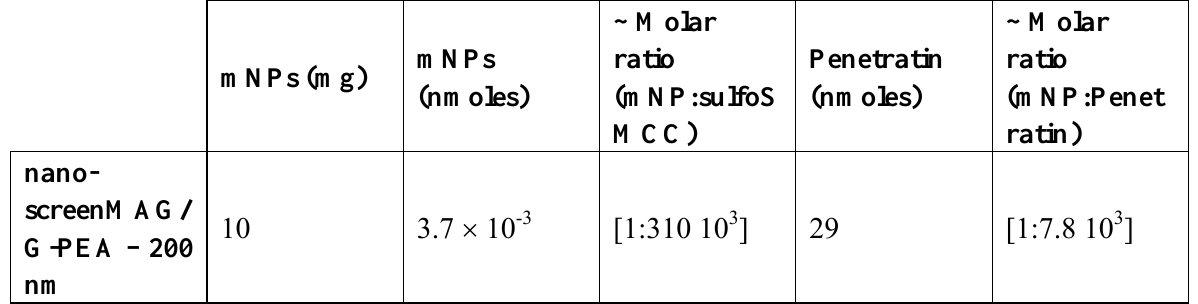
Table 1. Chemical description of the 200 nm NPs after functionalisation with penetratin. The concentration of NPs in a 1 mL sample is displayed in both mg and nmoles. The molar ratio of mNPs to sulfo-SMCC, (which was used for amine activation) is shown. The concentration of penetratin in each 1 mL sample and the molar ratio of mNPs to penetratin is